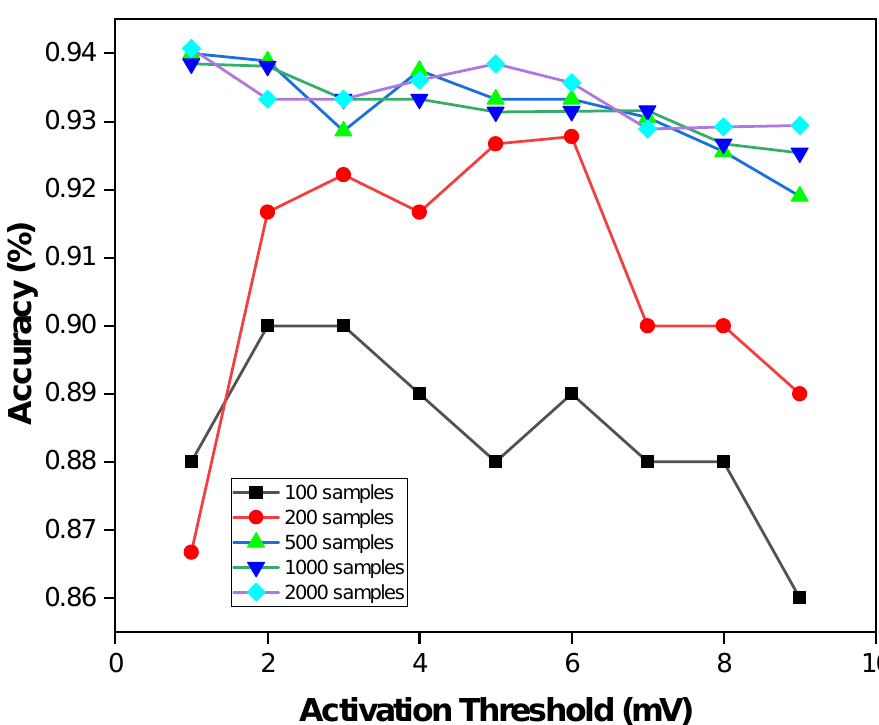
Figure 14. Accuracy impact with varying the